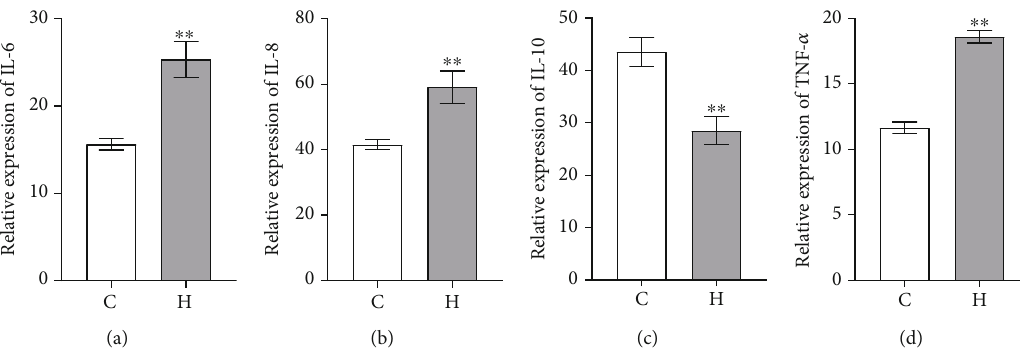
Figure 1: The levels of in fl ammatory factors in blood were detected. (a) The expression levels of IL-6. (b) The expression levels of IL-8. (c) The expression levels of IL-10. (d) The expression levels of TNF- α . ∗∗ P < 0 : 01 vs. healthy group. C: healthy group; H: CHF